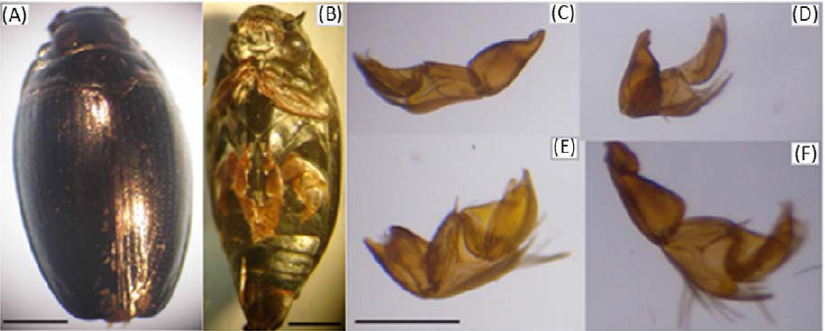
Figure 1. Light micrographs of the whirligig beetle. (A) Dorsal view of the beetle, demonstrating the overall shape. (B) Ventral view of the beetle showing the fore, middle and hind legs. (C&D) Micrographs of dissected middle right (C) and left (D) legs. (E&F) Micrographs of dissected hind right (E) and left (F) legs. Measurements of leg length ( L h and L m ) and area ( S h 2 and S m 2 ) were made from micrographs of dissected legs. The scale bars are 1